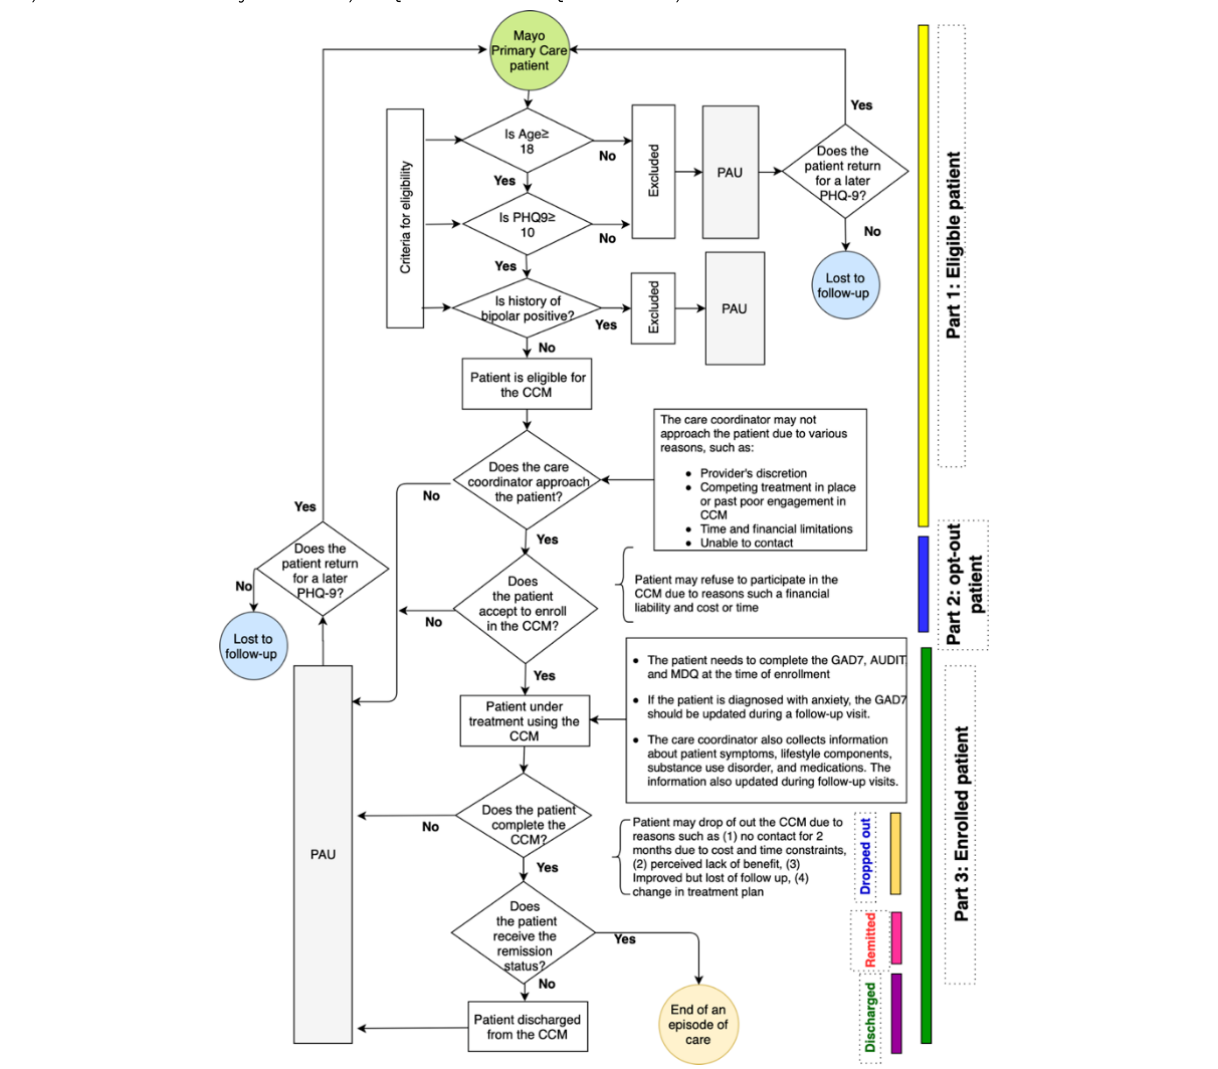
Figure 1. Data flow diagram of the Integrated Behavioral Health registry. AUDIT: Alcohol Use Disorders Identification Test; CCM: Care